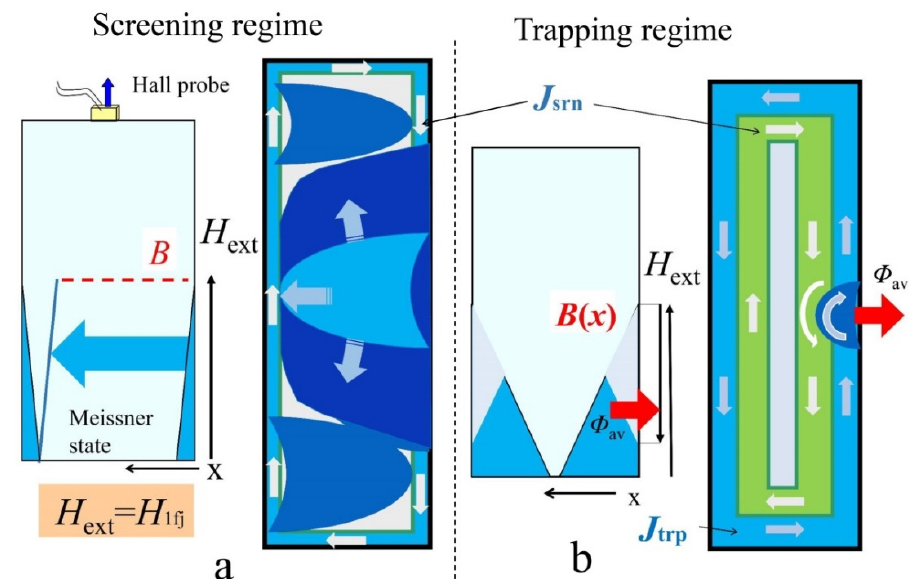
Figure 12. ( a , b ) Left side—a magnetic induction B ( x ) of Bean’s profile into plate before the 1st flux jumps in screening regime ( a ) and before the cascade in trapping regime appears ( b ); right side is cross section of plate perpendicular to magnetic field direction: a schematic representation of the flux avalanche entry process, corresponding to the 1st flux jump ( a ) and to the cascade creation ( b ).